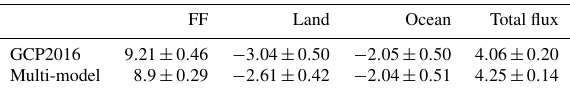
Table 3. Global Carbon budget for 2009 to 2011, estimated by the Global Carbon Project 2016 (first row, with river adjustment) and by the suite of models from this study (second row); all values are in PgCyr − 1 . Values are indicated by the model mean ± 1 σ error uncertainties, provided by GCP2016 or by the model standard devi-